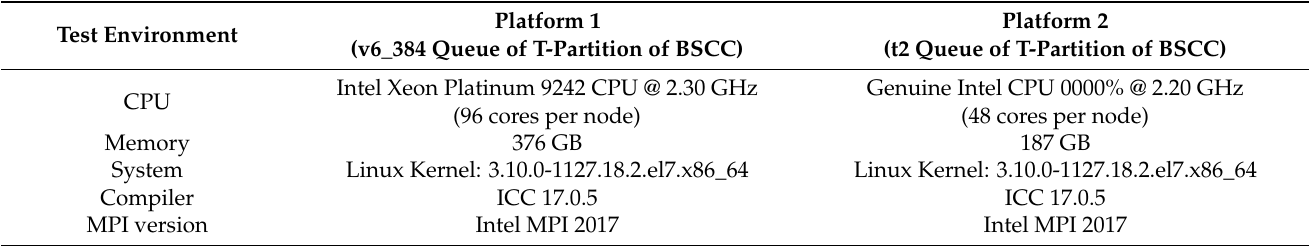
Table 2. The specific configuration of the supercomputing